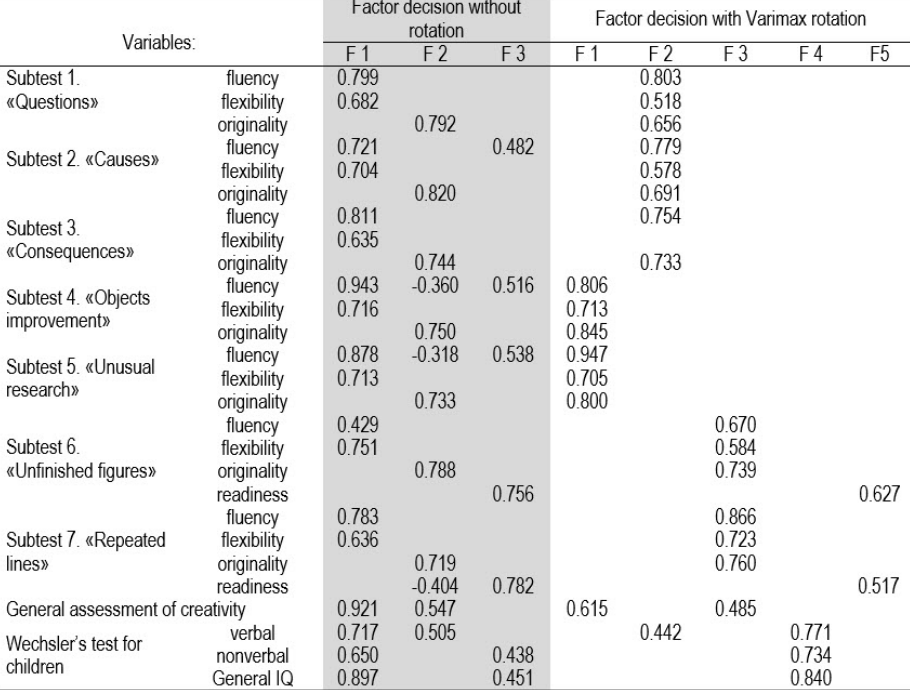
Factor analysis of creativity and intelligence indicators in a sample of 115